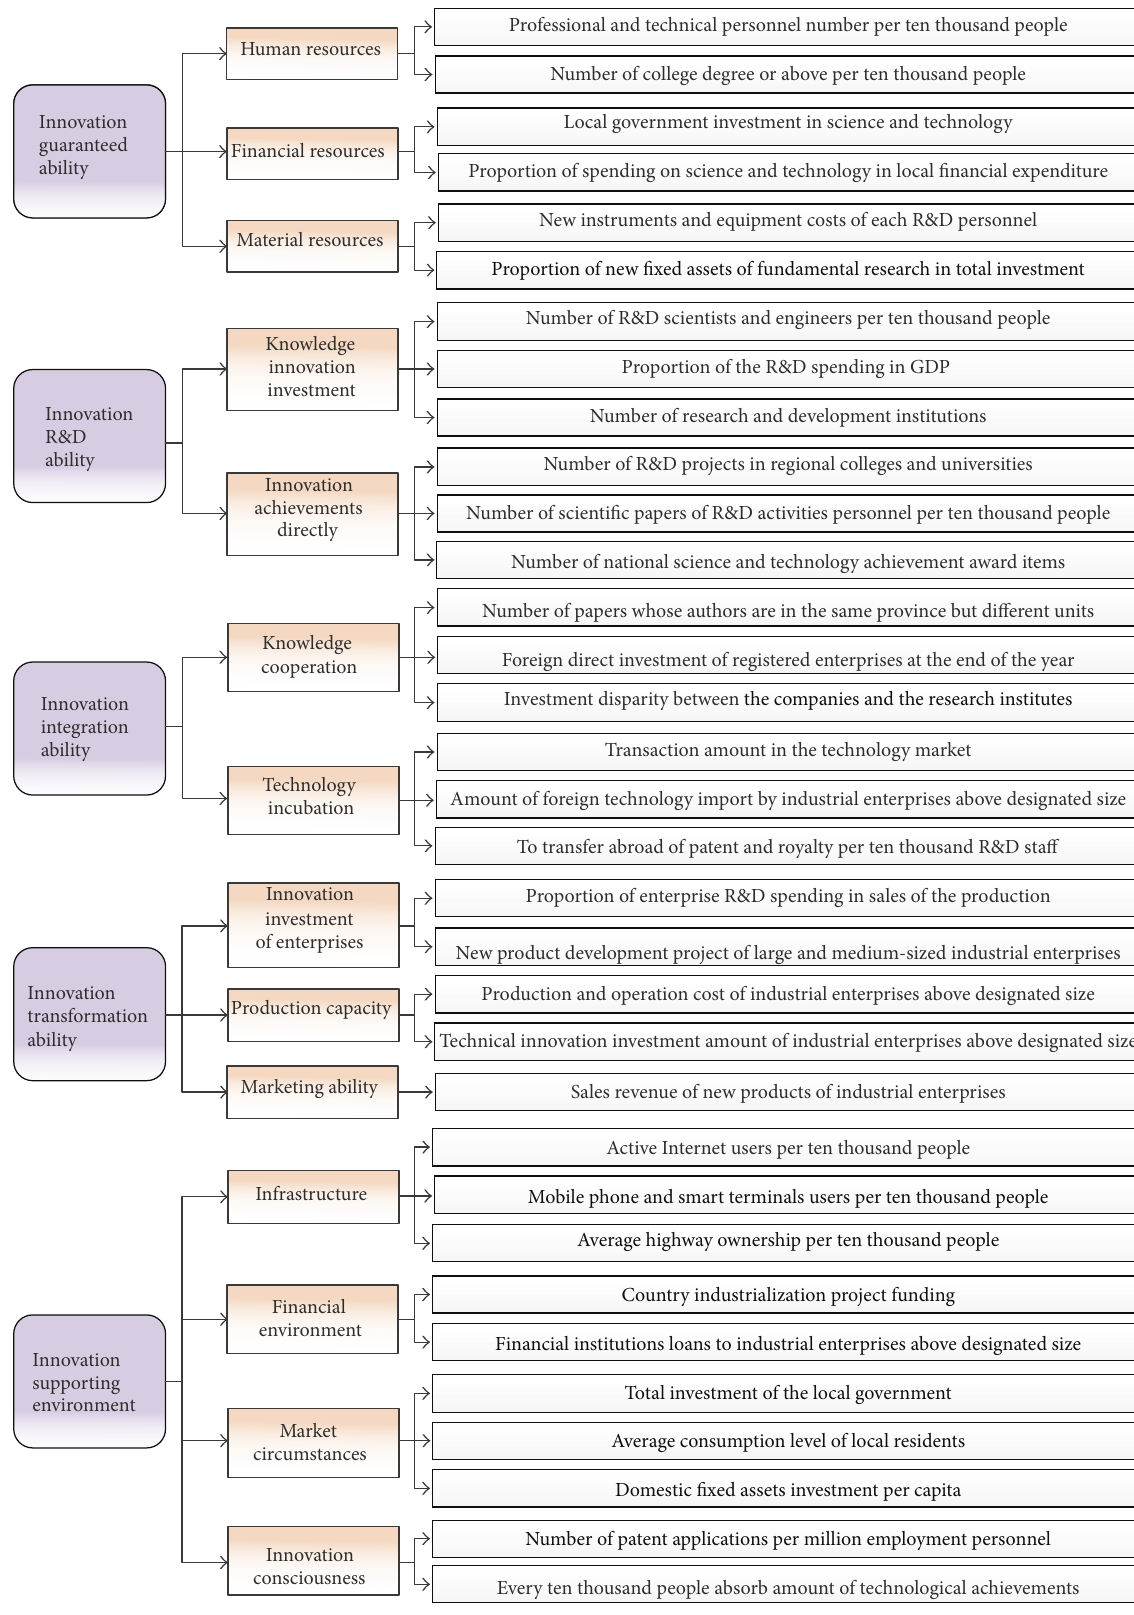
Figure 4: The source data used in the analyzing of regional collaborative